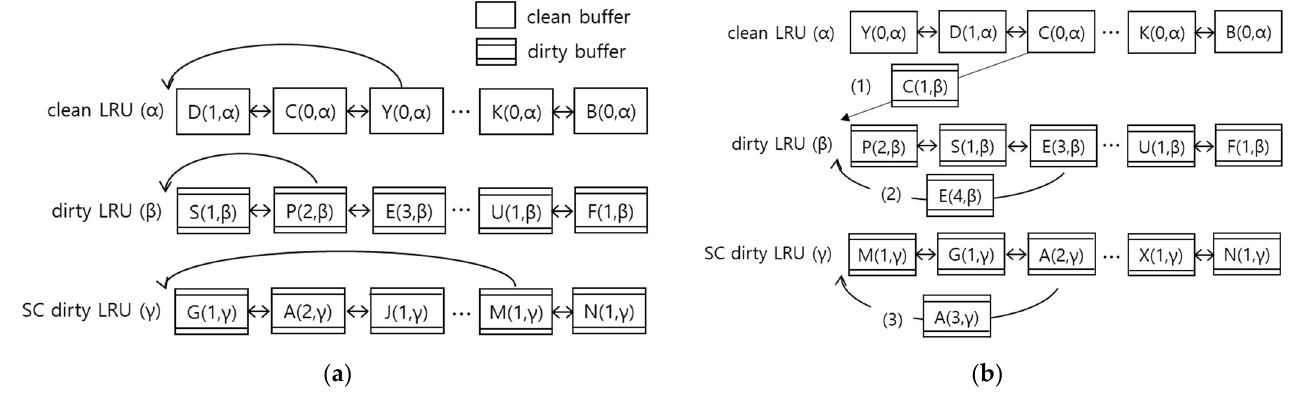
Figure 1. Main operations of the CFLRU-ER-SC policy. ( a ) Read hit; ( b ) write hit.